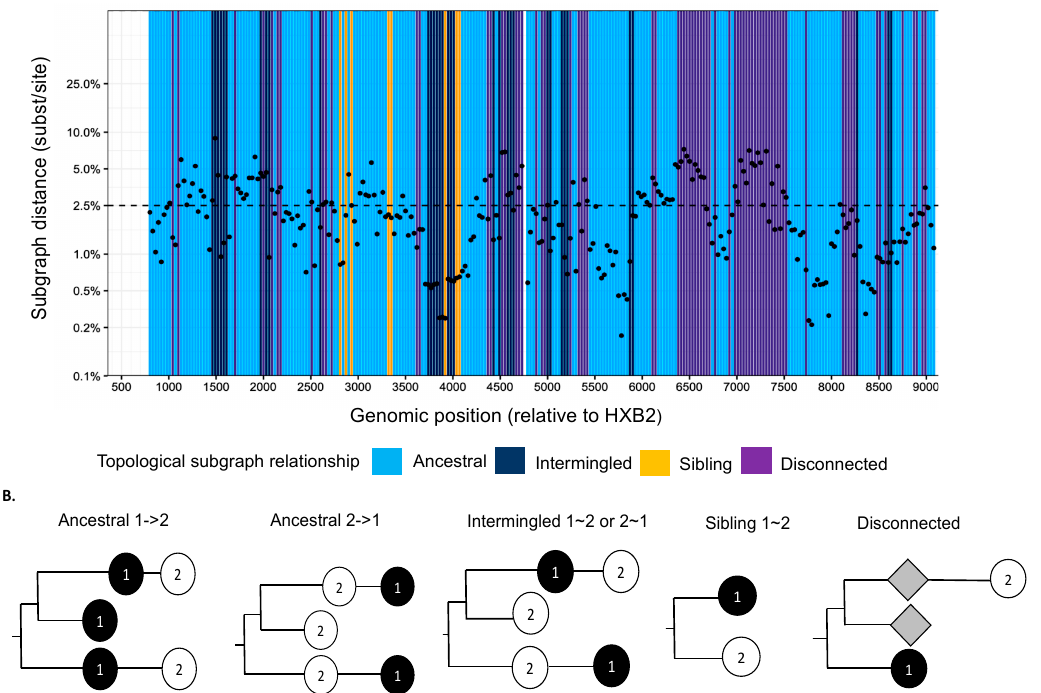
Figure 2. ( A ) Phyloscan plot showing deep-sequence phylogenies reconstructed at 250 bp genomic window intervals across the genome. Ancestral state reconstruction was used to attribute phylogenetic lineages to individuals, and phylogenetic subgraphs were defined as groups of lineages that were attributed to the same individual. For a pair of individuals, the scan plots show the shortest patristic distance between subgraphs of both individuals ( y -axis) and the topological relationship between subgraphs of both individuals (colors) across the genome (ancestral to one another (light blue), siblings (yellow), intermingled (dark blue), or disconnected (purple)). ( B ) Description of topological relationship between subgraphs in deep-sequence phylogenies. The phylogenetic topology or ordering of subgraphs is used to infer the likely direction of transmission between individuals [48]. Ancestral 1->2 means that at least one subgraph from individual 1 is phylogenetically adjacent to a subgraph from individual 2, and that all adjacent subgraphs from individual 1 are ancestral to those of individual 2. This phylogenetic pattern is consistent with transmission from individual 1 to individual 2, possibly via unsampled intermediates. Similarly, ancestral 2- > 1 means at least one subgraph from individual 1 is phylogenetically adjacent to a subgraph from individual 2, and that all adjacent subgraphs from individual 1 are descendent from those of individual 2. This phylogenetic pattern is consistent with transmission from individual 2 to individual 1, possibly via unsampled intermediates. Intermingled 1~2 means that at least one subgraph from individual 1 is phylogenetically adjacent to one subgraph from individual 2, and that there are adjacent subgraphs from individual 1 ancestral to those of individual 2, and vice versa. Sibling 1~2 means that at least one subgraph from individual 1 is phylogenetically adjacent to one subgraph from individual 2, and that the adjacent subgraphs are phylogenetically next to each other. These two patterns indicate that the two individuals are closely related, but there is no evidence for the direction of transmission. Disconnected refers to individuals who have subgraphs that are not adjacent to each other. This pattern suggests that the two individuals are phylogenetically